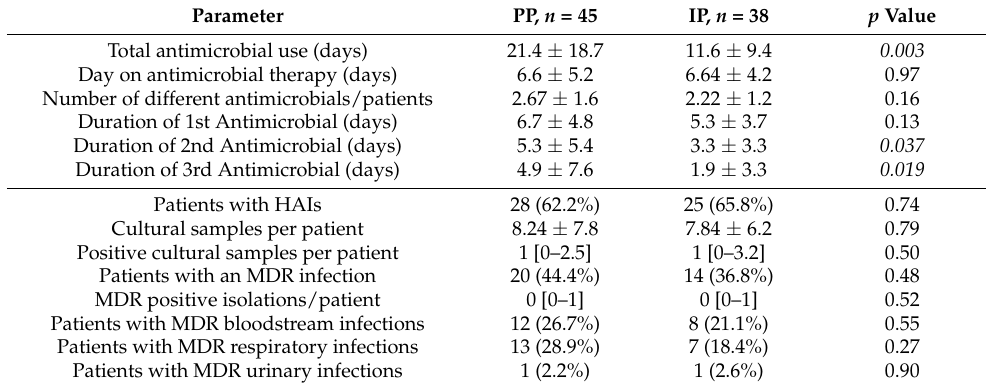
Table 3. Antimicrobial therapy, cultural samples and infections in the study population, divided for year of admission.